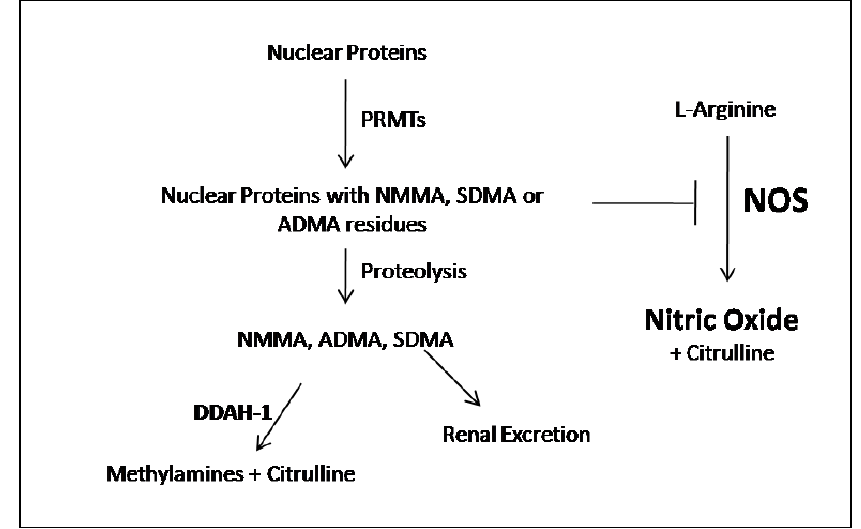
Figure 1. The role of DDAH1 in the metabolism of the nitric oxide synthase (NOS) antagonists asymmetric dimethylarginine (ADMA) and NG-monomethylarginine (NMMA). PRMTs, protein arginine methyltransferases; SDMA, symmetrical